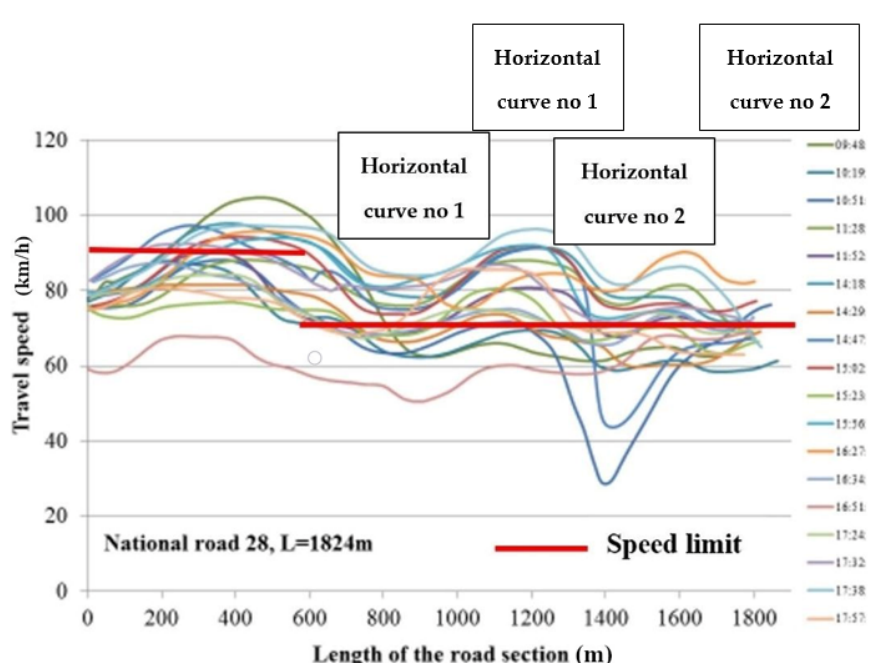
Figure 3. Selected drives behind the leader showing the impact of horizontal curves located close to each other on the variability of vehicles’ free-flow speed.